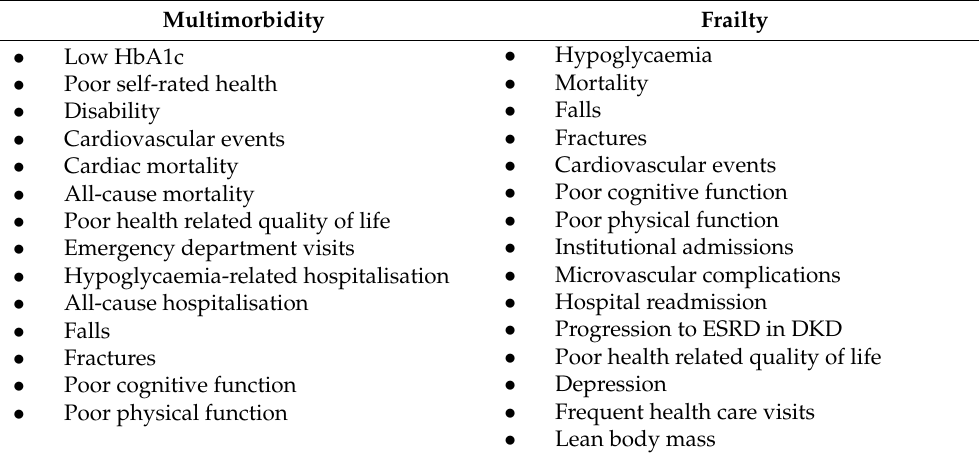
Table 4. Similar outcomes predicted by multimorbidity and frailty in older people with